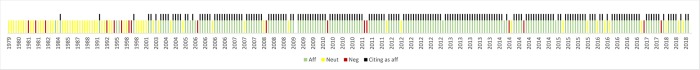
Reception of Franke and Kaul 1978.